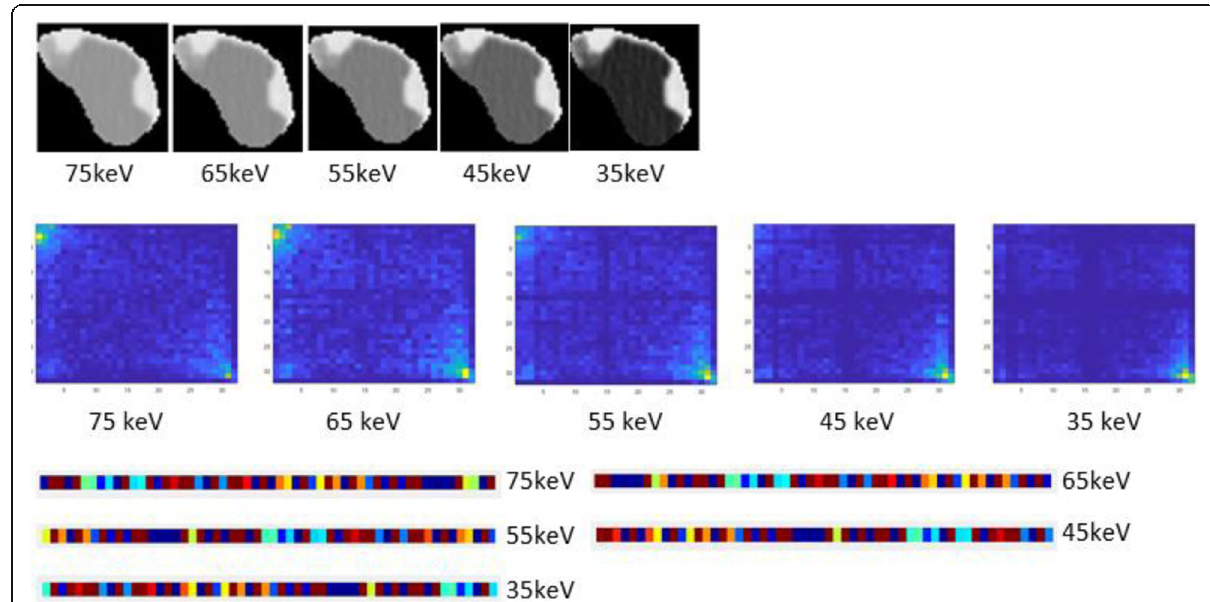
Fig. 3 An example of one polyp slice at different energy channel and the corresponding extracted texture features. The first row is the raw computed tomography image; the second row is the co-occurrence matrices (CMs) extracted from the spectral images; the third row is the Haralick features extracted from the CMs